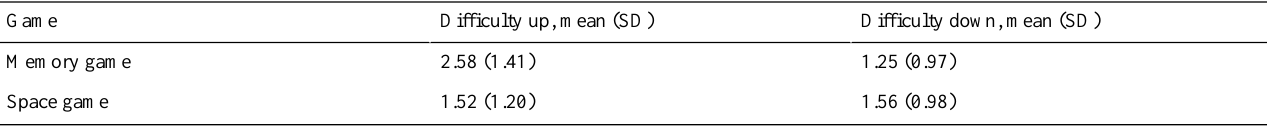
Table 1. Adaptive difficulty changes during game: mean and SD results of in-game adaptive difficulty changes for both games in the second session with students.